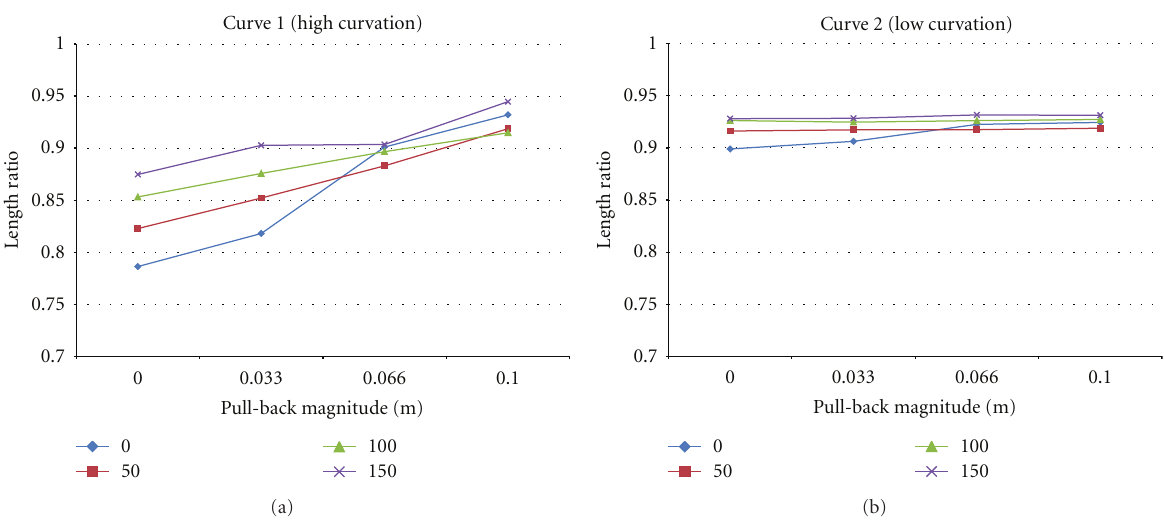
Figure 5: Ratio (shortest path/actual path length) for curve 1 (high curvation) and curve 2 (low curvation) for the di ff erent attraction forces (colours) and di ff erent pull-back values ( x